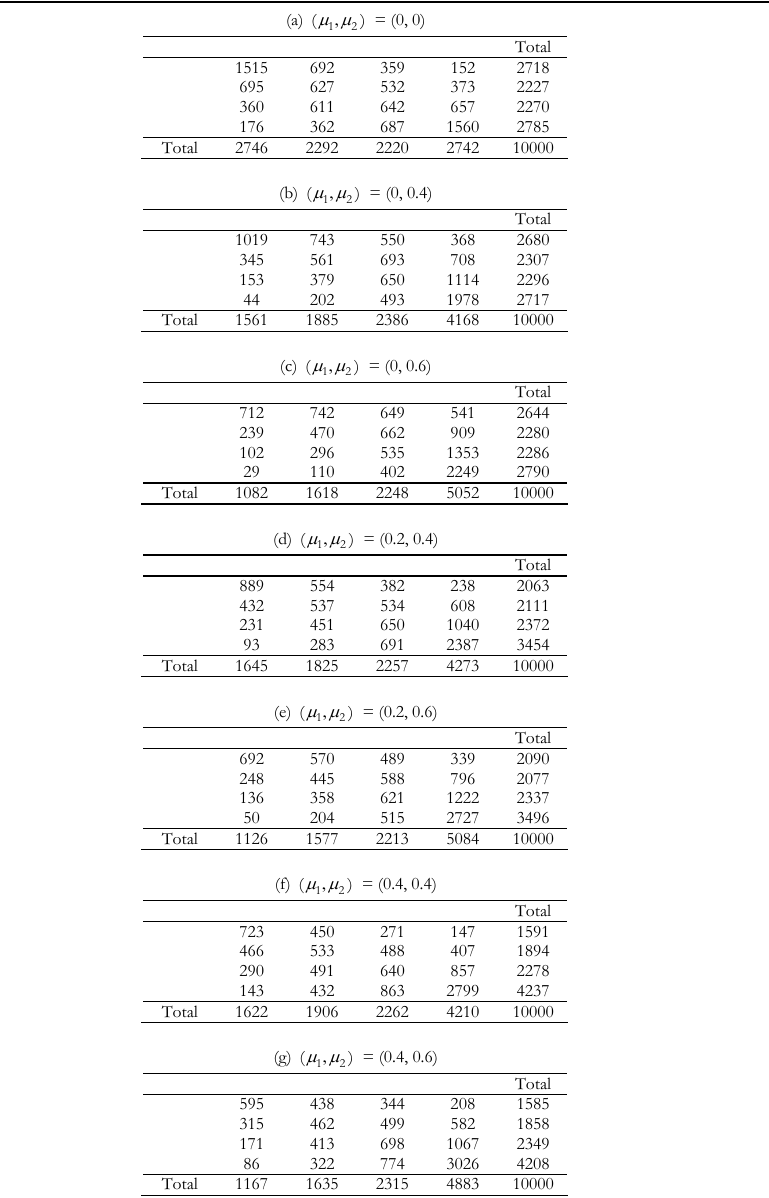
The 4  4 tables of sample size 10000, formed by using cutpoints for each variable at 0 6   , 0 and 0 6  , from an underlying bivariate normal distribution with the conditions 2 1 0   